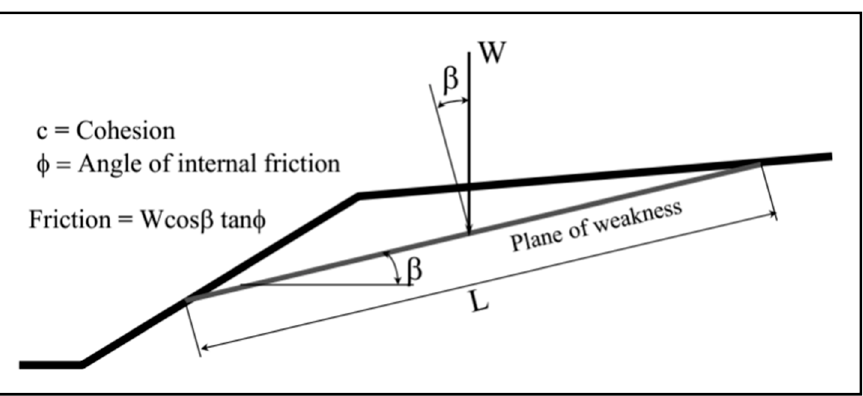
Figure 3. Recommended Design Methods. Figure 4. Internal Stability of a Soil Slope.